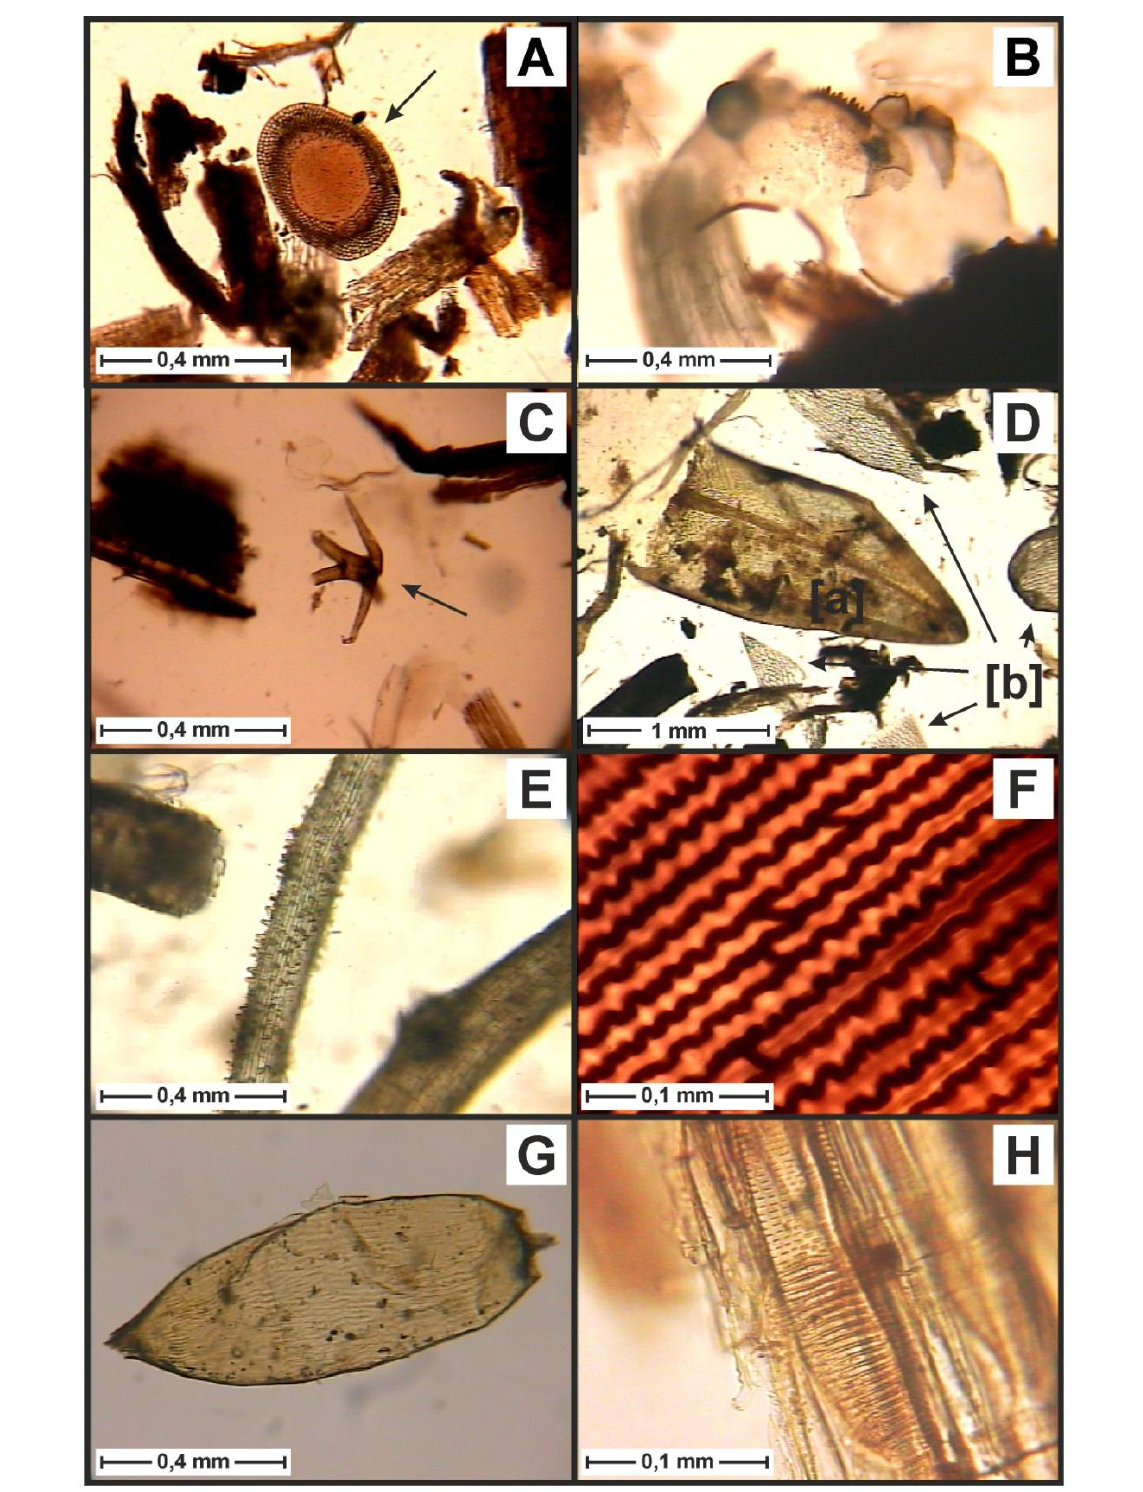
Fig. 2. Examples of macrofossils - bioindicators of the wetland environment noted in the cores analysed. Bioindicators of aquatic conditions: A - Bryozoa statoblast (Ujazd/Zandrzyny), B - Chironomidae head capsule (Las Turbina), C - Nymphaeaceae idioblast (Sławięcice 2). Bioindicators of fen and swamp environments: D - brown moss ( Calliergon sp.) [a] and Sphagnum sp. [b] leaves (Sławięcice 1), E - Cyperaceae roots (Sławięcice 1), F - Equisetum epidermis (Sławięcice 2), G - Typha cf angustifolia seed (Łany Małe), H - Alnus glutinosa wood (Sławięcice